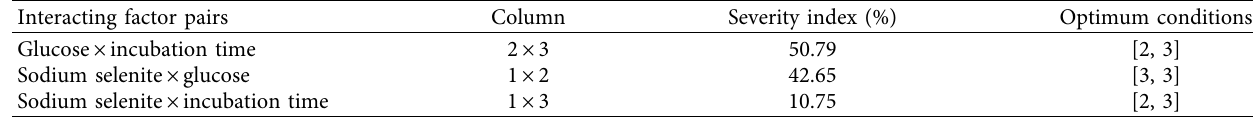
Table 3: The interactions effects of studied factors on growth inhibiting of Candida albicans . Interacting factor pairs